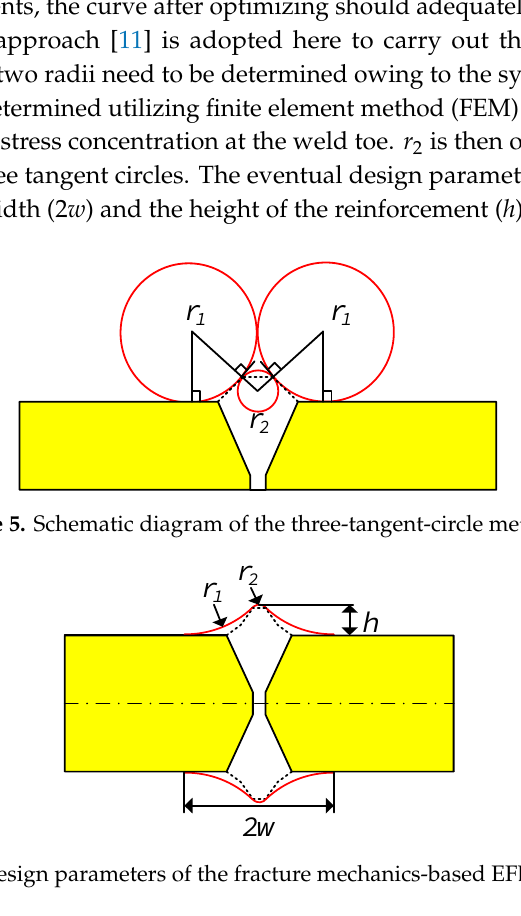
Figure 6. Design parameters of the fracture mechanics-based EFBC method.